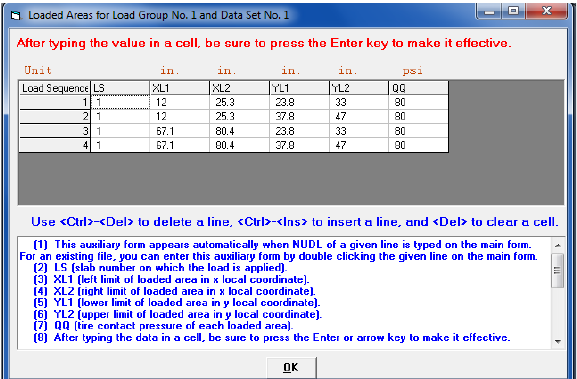
Figure 6: Data on load areas in KENSLAB